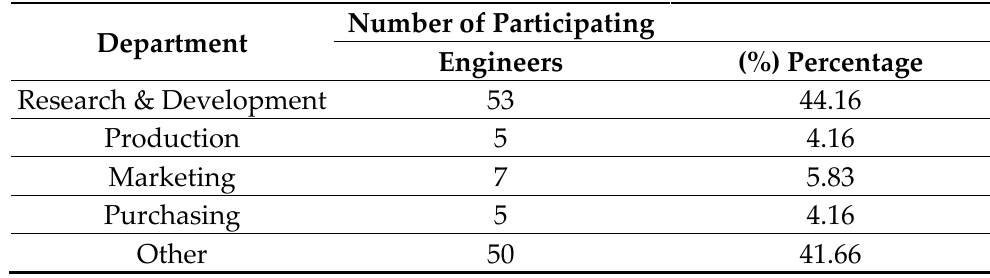
Table 1. Distribution of participants according to their departments.